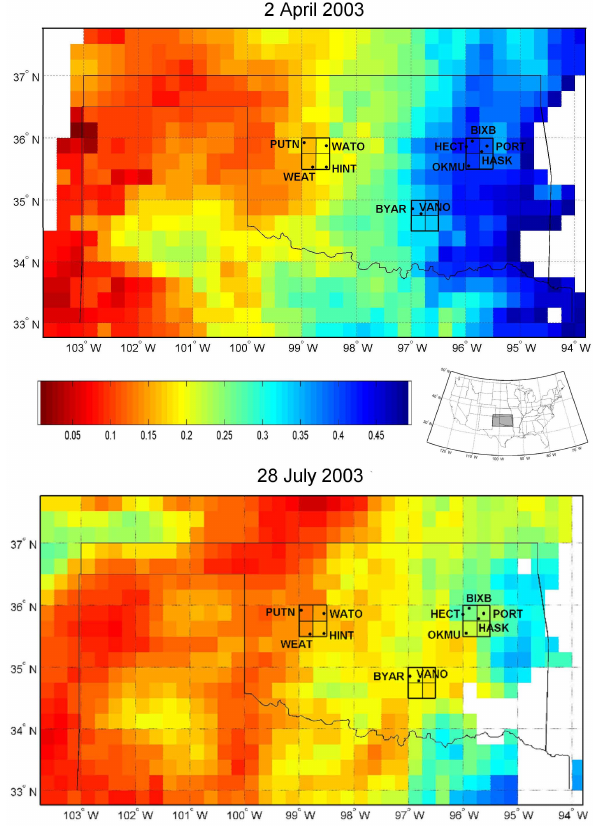
Fig. 1. AMSR-E 0.25 degree gridded absolute soil moisture (m 3 m − 3 ) retrievals (AMSR-E VUA abs) from the Land Parameter Retrieval Model (Owe et al., 2008) for 2 April 2003 (upper panel) and 28 July 2003 (lower panel). White areas indicate grid cells out- side the sensor swath (upper panel, northwest corner) or masked-out grid cells of non-convergence (east and southeast). The AMSR-E grids represented by an Oklahoma (inset, next to key) Mesonet ob- servation stations are bold